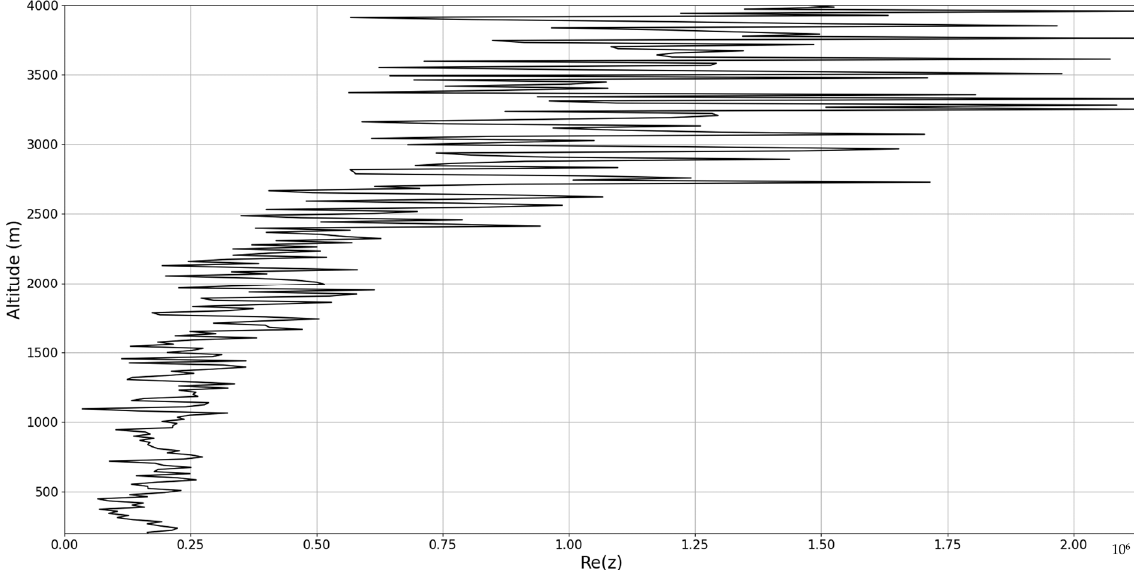
Figure 18. Zoomed-in Re profile, λ = 1064 nm , Gala ț i, Romania, 22 December 2021.